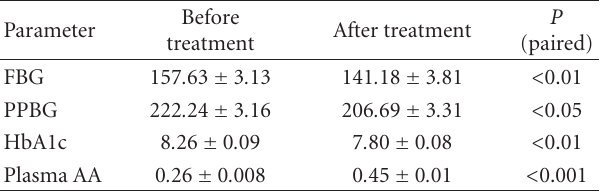
Table 3: E ff ect of metformin with vitamin C on FBG, PPBG, HbA1c, and plasma AA in patients with type 2 diabetes mellitus after 12 weeks of